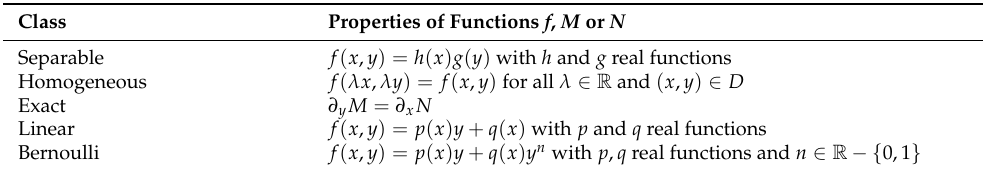
Table 7. Typical classification of first-order ordinary differential